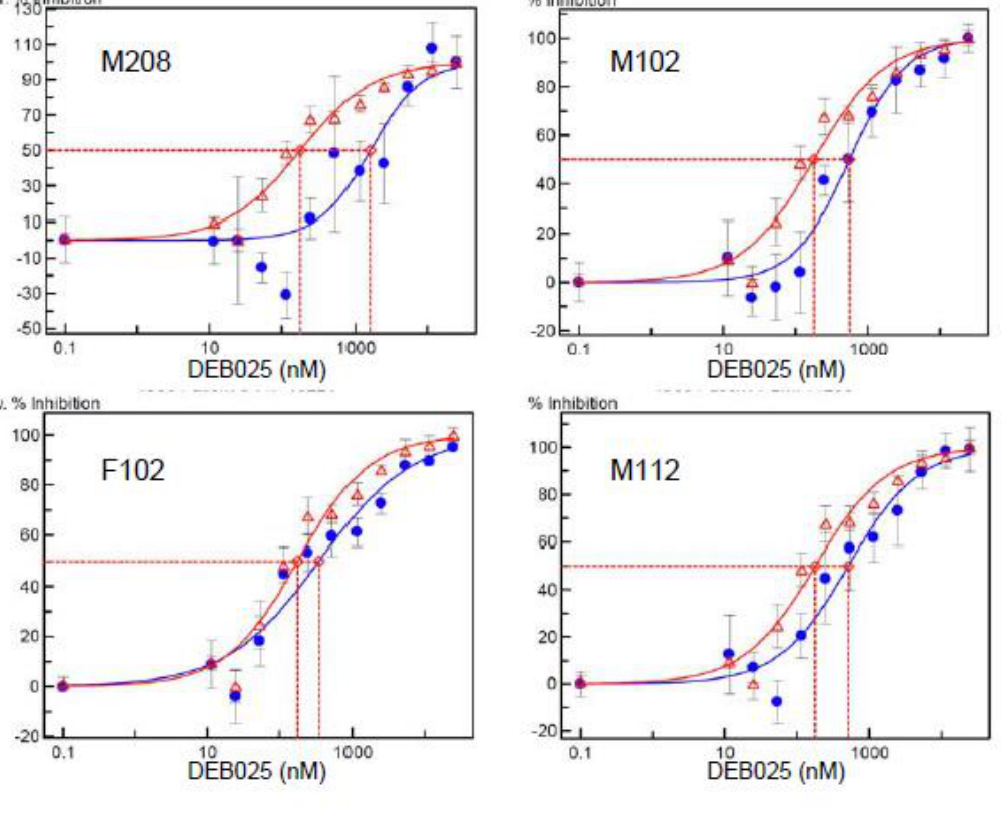
Figure 2. Inhibition curves of recombinant viruses carrying the capsid gene from four patients’ serum specimens. These patients had been nonresponders in a clinical study evaluating DEB025 in HIV-1/HCV-co-infected patients (Flisiak et al. , 2008). For each panel, the average percent inhibition effectuated by various concentrations of DEB025 for the recombinant virus (in blue) and the reference virus (strain NL4-3, in red) are depicted. The antiviral activity of DEB025 was determined in the DeCIPhR assay system as described in the Experimental